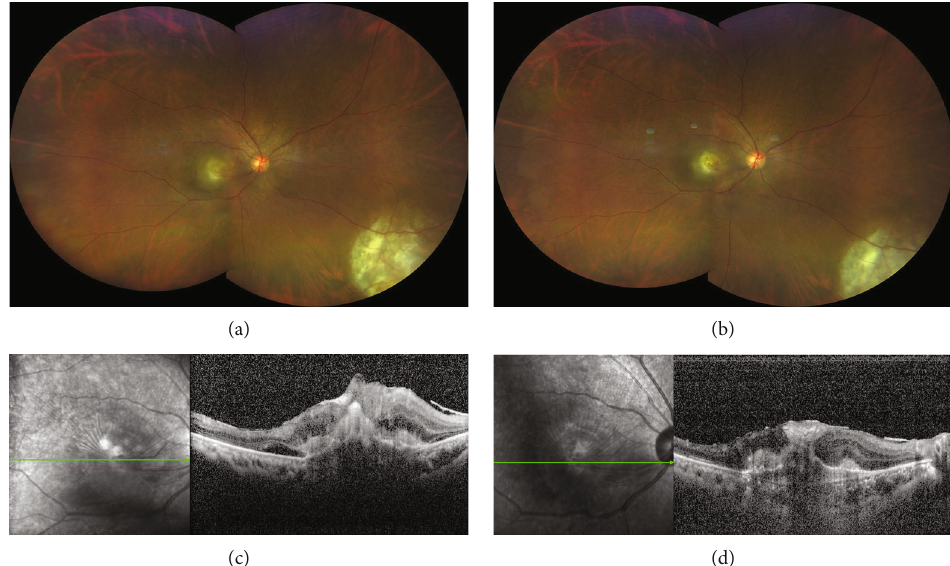
Figure 4: Comparation of lesions before and after the treatment of anti-VEGF. (a, b) The color fundus photograph of the right eye before and after treatment. (a) The lesions have obscure boundaries and are surrounded with hemorrhages. (b) The yellow-white lesions in the macular and inferonasal peripheral retina. Retina were well-demarcated and shrunk, hemorrhage was absorbed, and exudation around the optic nerve reduced signi fi cantly. (c, d) The OCT images of RAP before and after treatment: (c) intra- and subretinal fl uids were increased; (d) sub- and intraretinal fl uids were partly absorbed, and central retinal thickness was reduced from 841 μ m to 690 μ